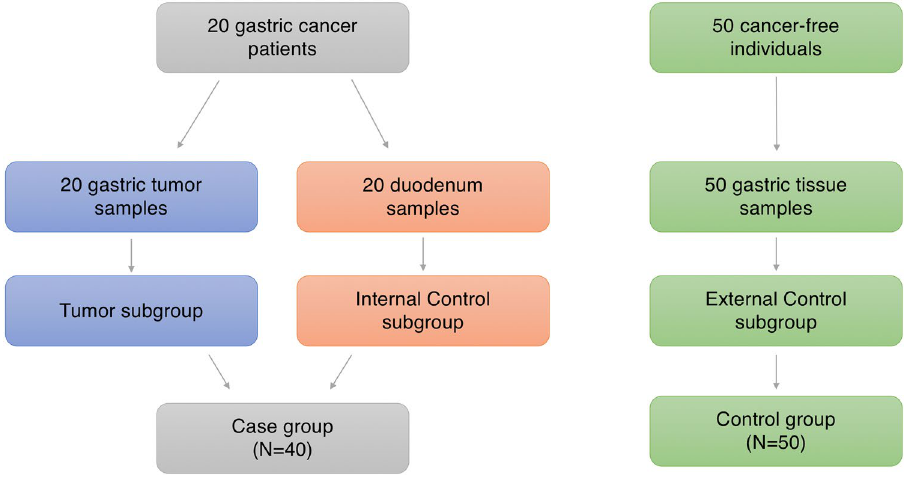
Figure 7. Schematic visualization of the sampling